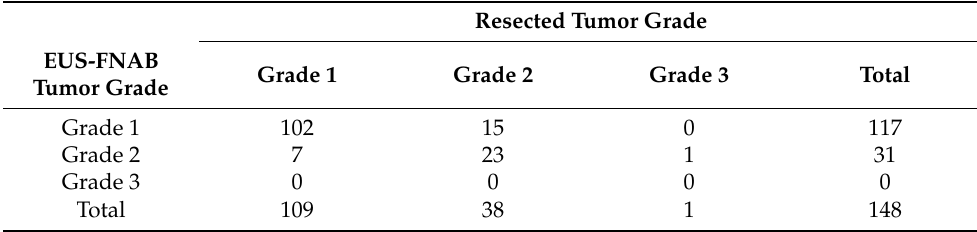
Table 4. Concordance of PNEN grading between EUS-FNAB specimens and surgical specimens